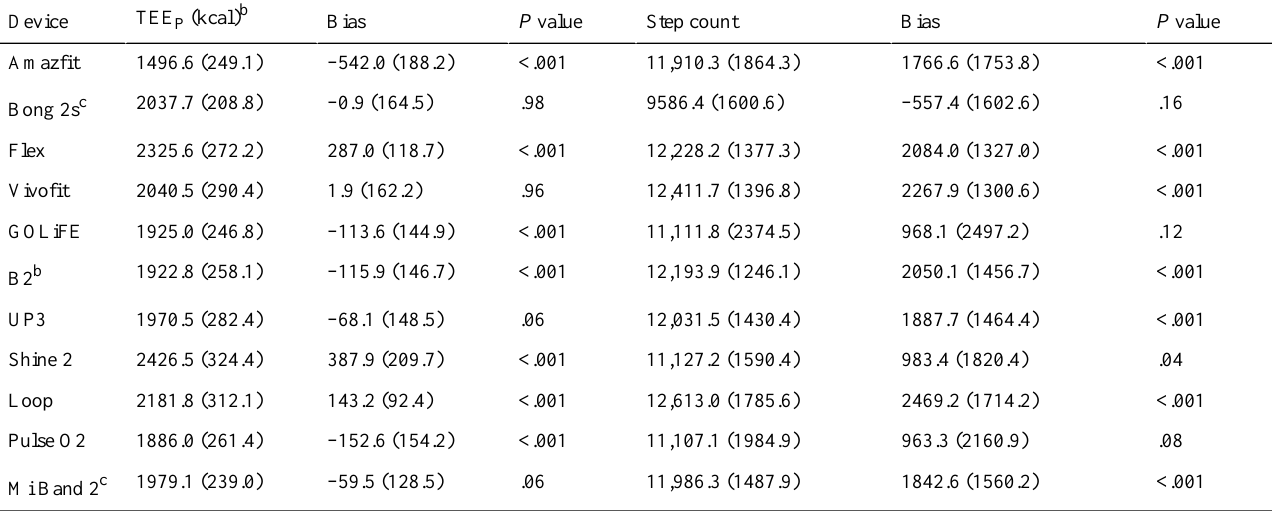
Table 4. Mean, standard deviation, and bias between wrist-wearable activity devices and criterion measures for total energy expenditure (kcal) and step counts